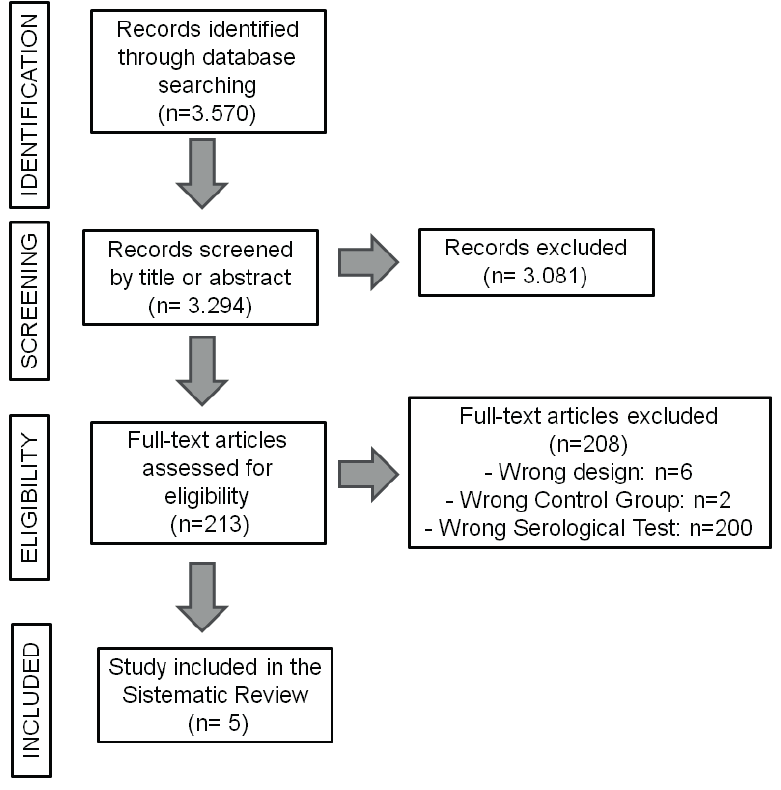
Figure 1 - Flow chart of study